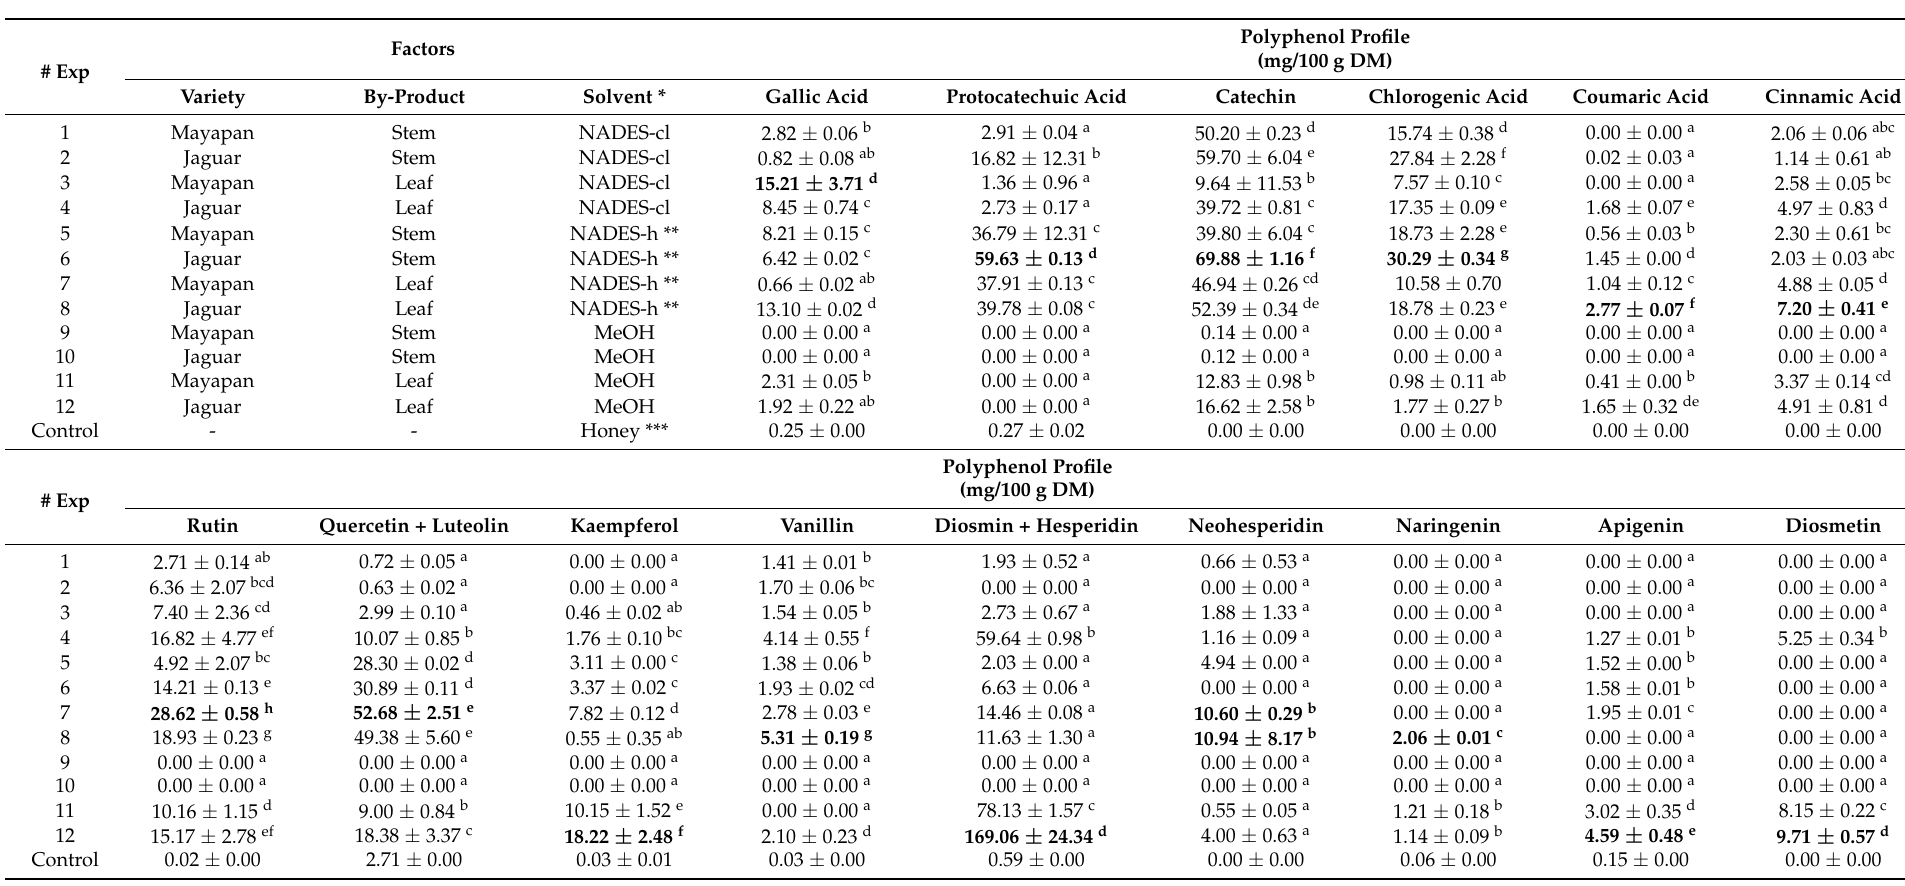
Table 2. Polyphenol profile from habanero pepper ( Capsicum chinense Jacq.) by-products